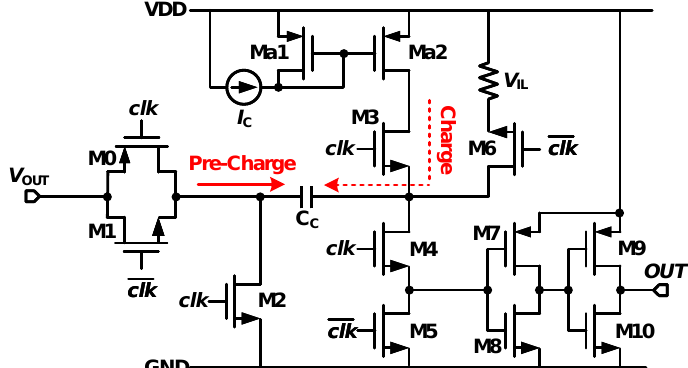
Figure 4. Schematics of the Voltage Sensor.